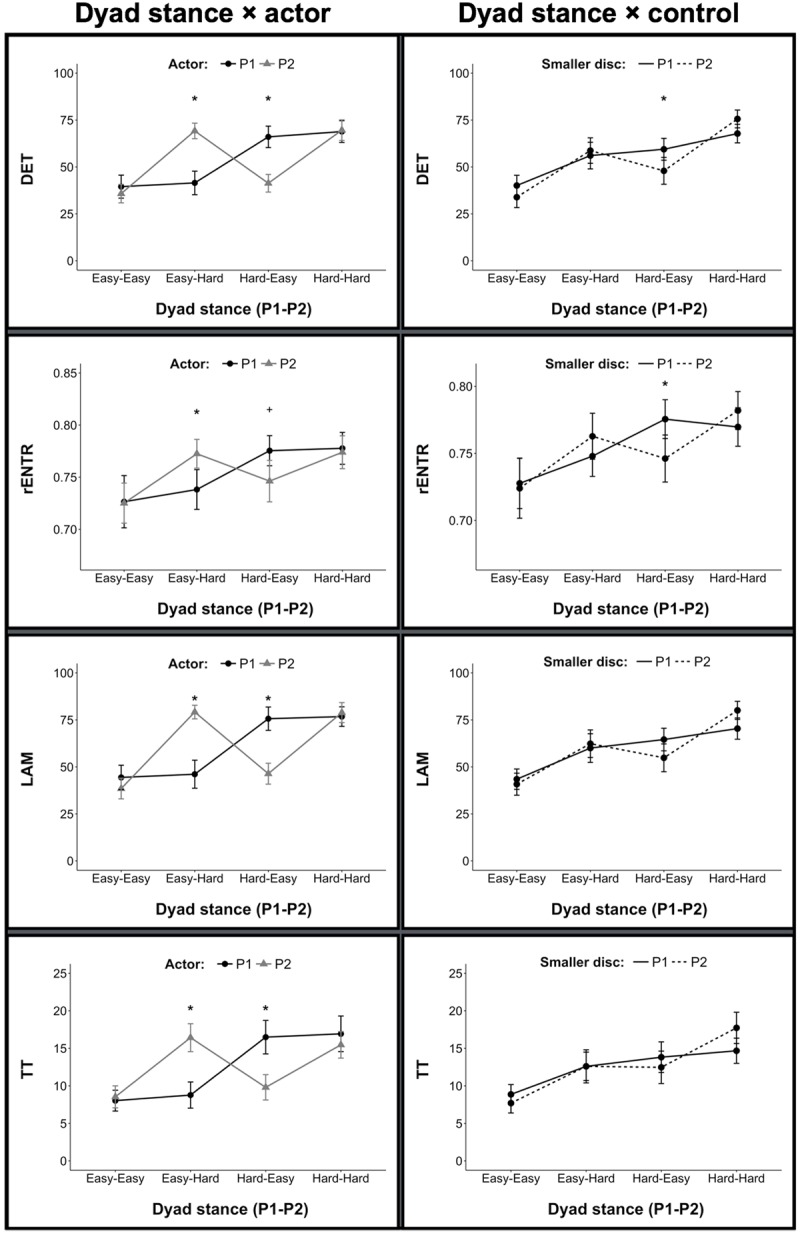
Measures of intra-personal hand-torso coordination. Here and in all remaining figures (unless otherwise noted), error bars represent 95% confidence intervals. (∗) denotes p < 0.05; (+) denotes p < 0.10.